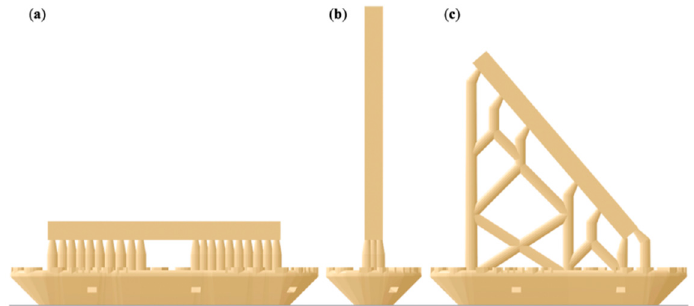
Figure 1. Illustration of the bar-shaped specimens in an ( a ) horizontal, ( b ) vertical, and ( c ) diagonal printing orientation including support structures and rafts.